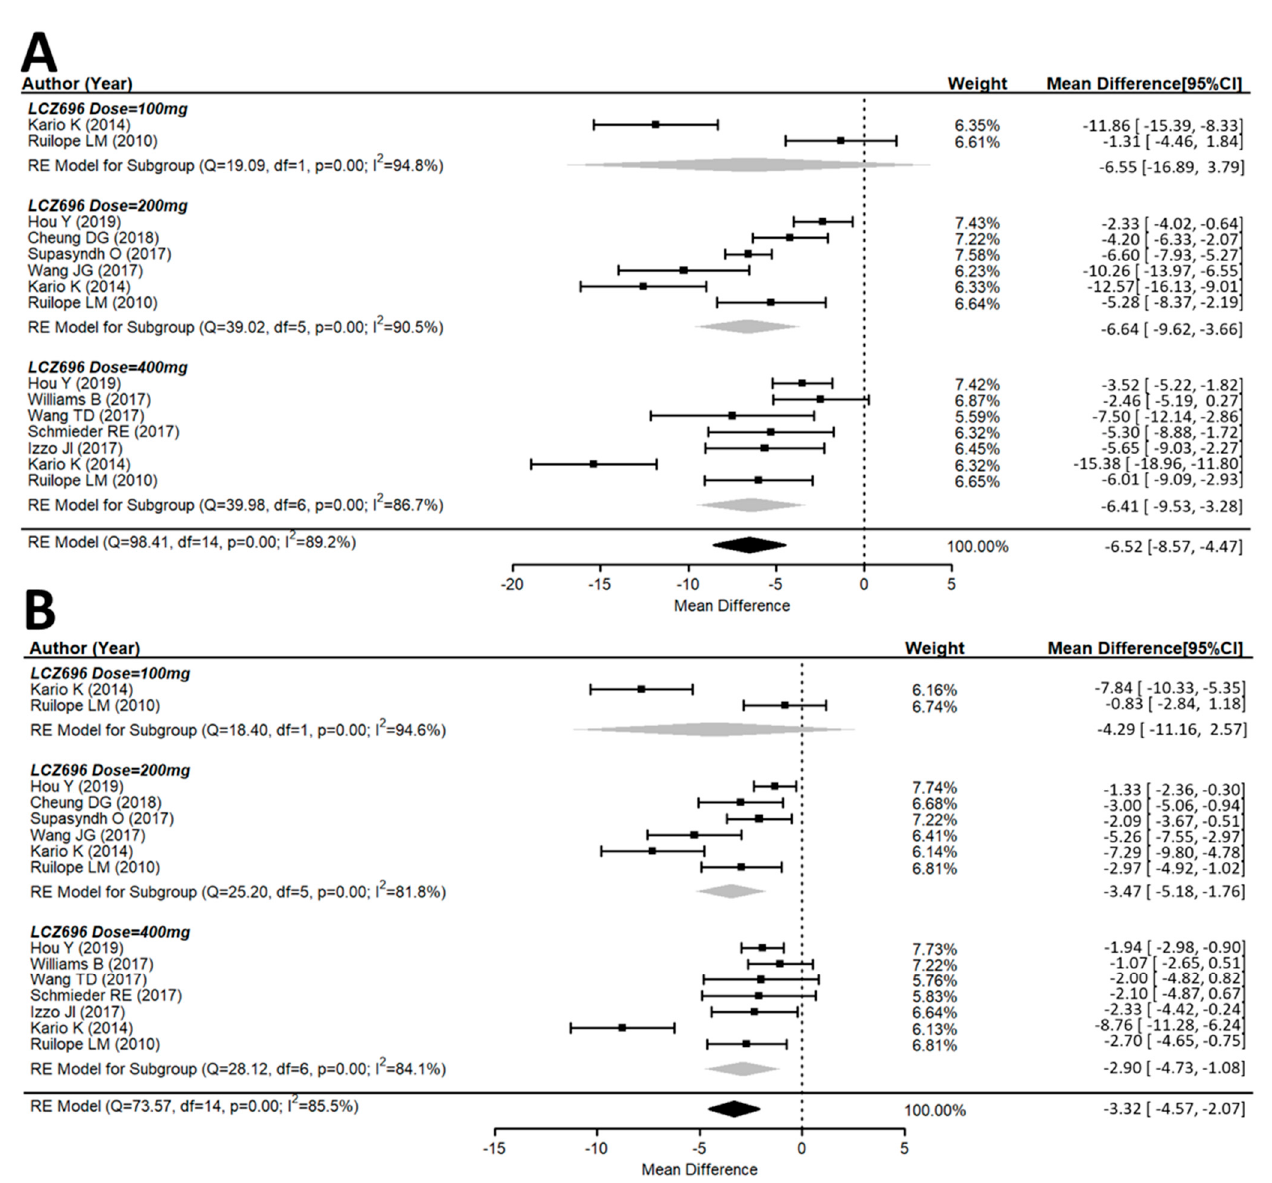
Figure 2. Forest plot of ( A ) msSBP and ( B ) msDBP. Comparisons of LCZ696 with a control group. msSBP, mean sitting systolic blood pressure; msDBP, mean sitting diastolic blood pressure.